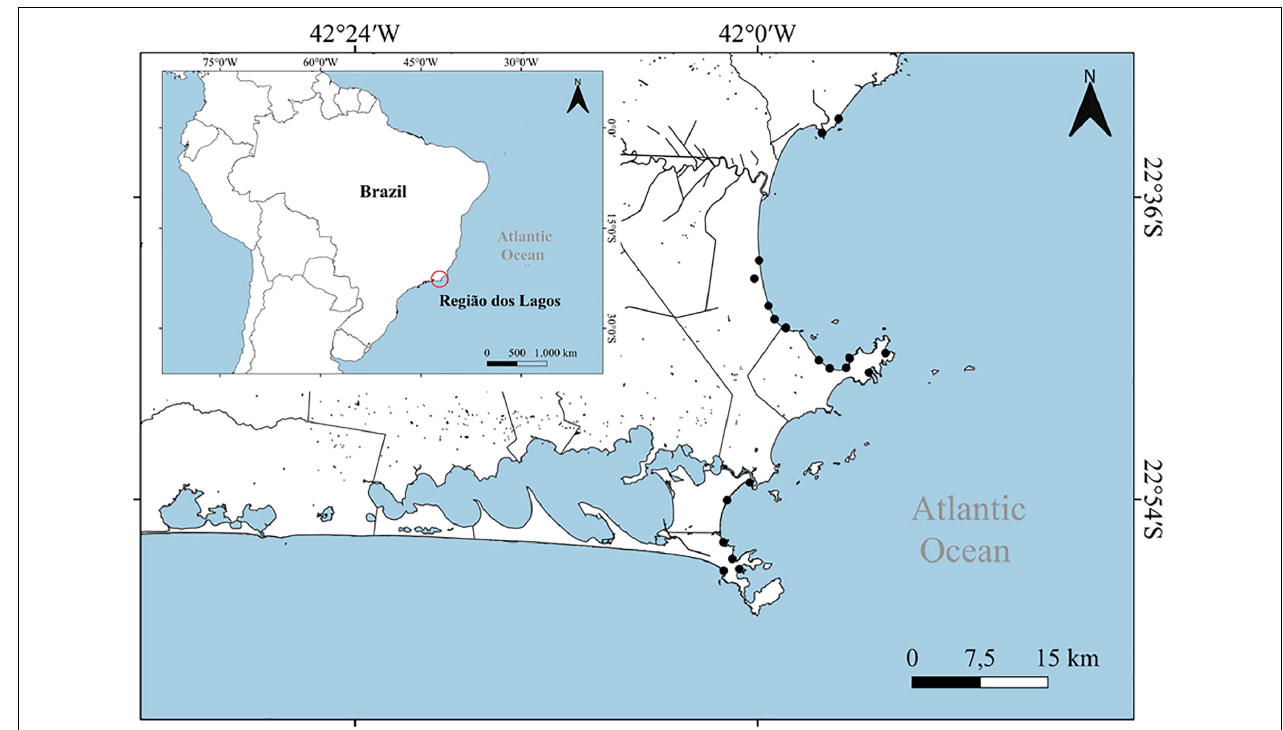
FIGURE 2 | Location of the green sea turtle strandings in the Região dos Lagos region, eastern coast of the state of Rio de Janeiro, southeastern Brazil.